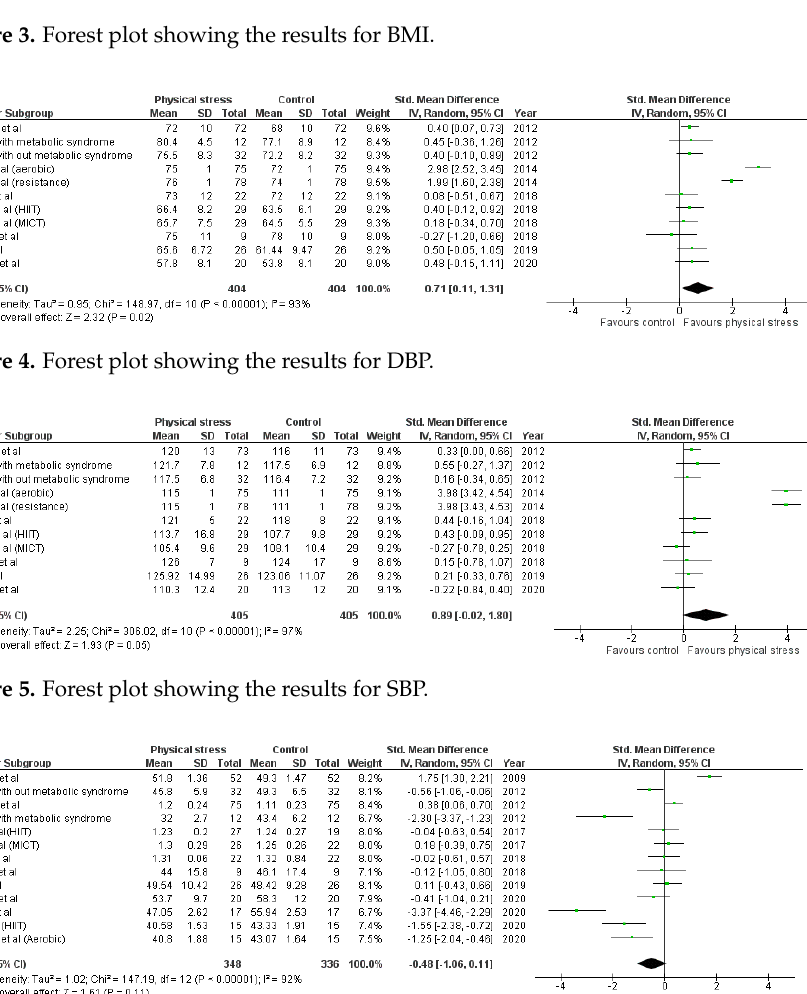
Figure 6. Forest plot showing the results for HDL.